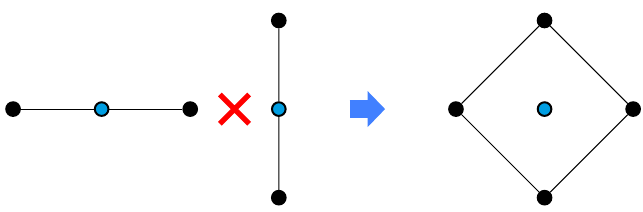
Figure 6. The toric diagram of F 0 can be obtained as the product of two copies of the toric diagram of . In both cases we use the central point of the toric diagram to take the C 2 / Z 2